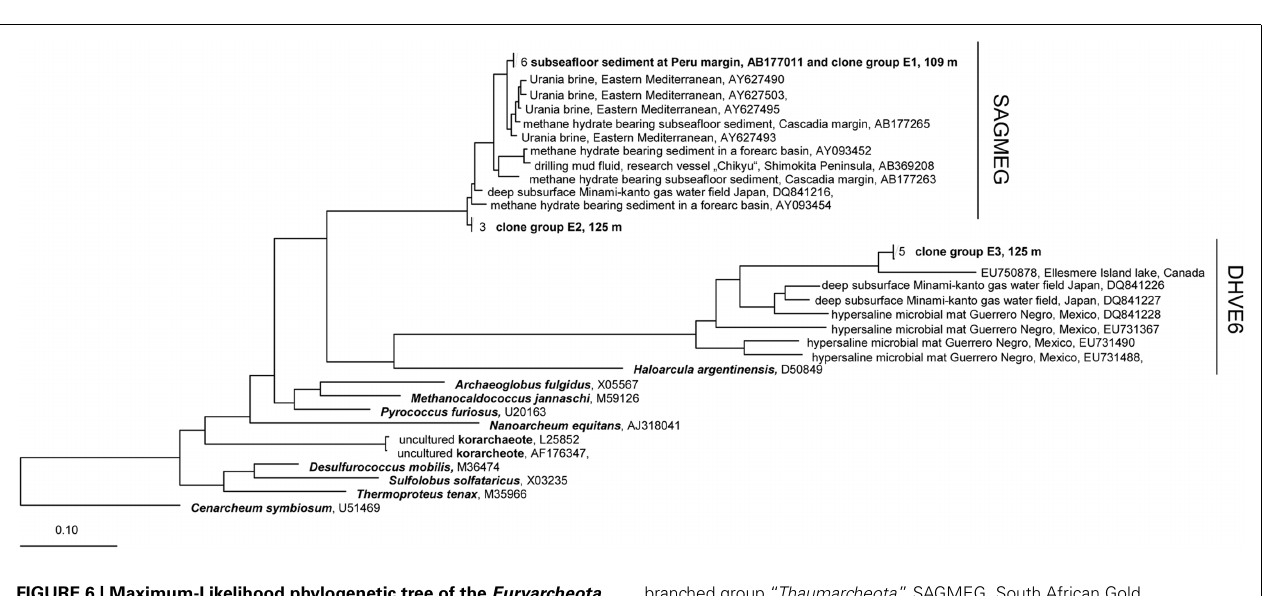
FIGURE 6 | Maximum-Likelihood phylogenetic tree of the Euryarcheota showing clades found in terrestrial CBIS post-impact sediment. The tree was rooted with Cenarchaeum symbiosum as a representative of the deeply